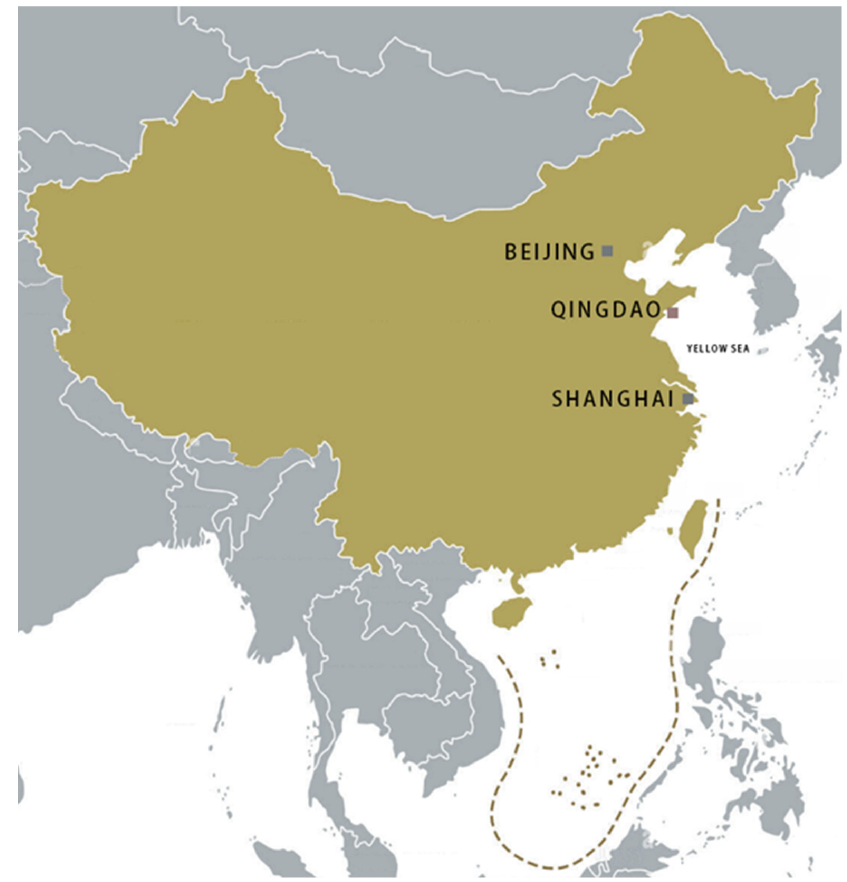
Figure 2. The location of Qingdao in China.